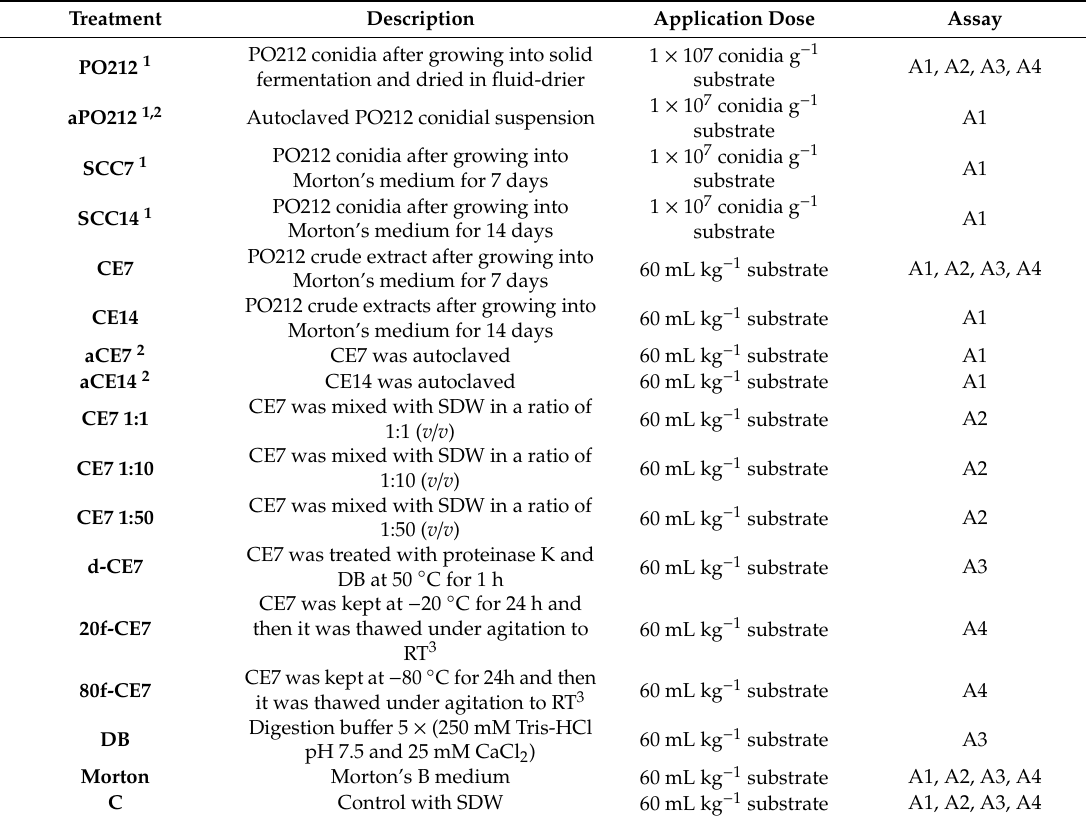
Table 1. Description of treatments applied in this